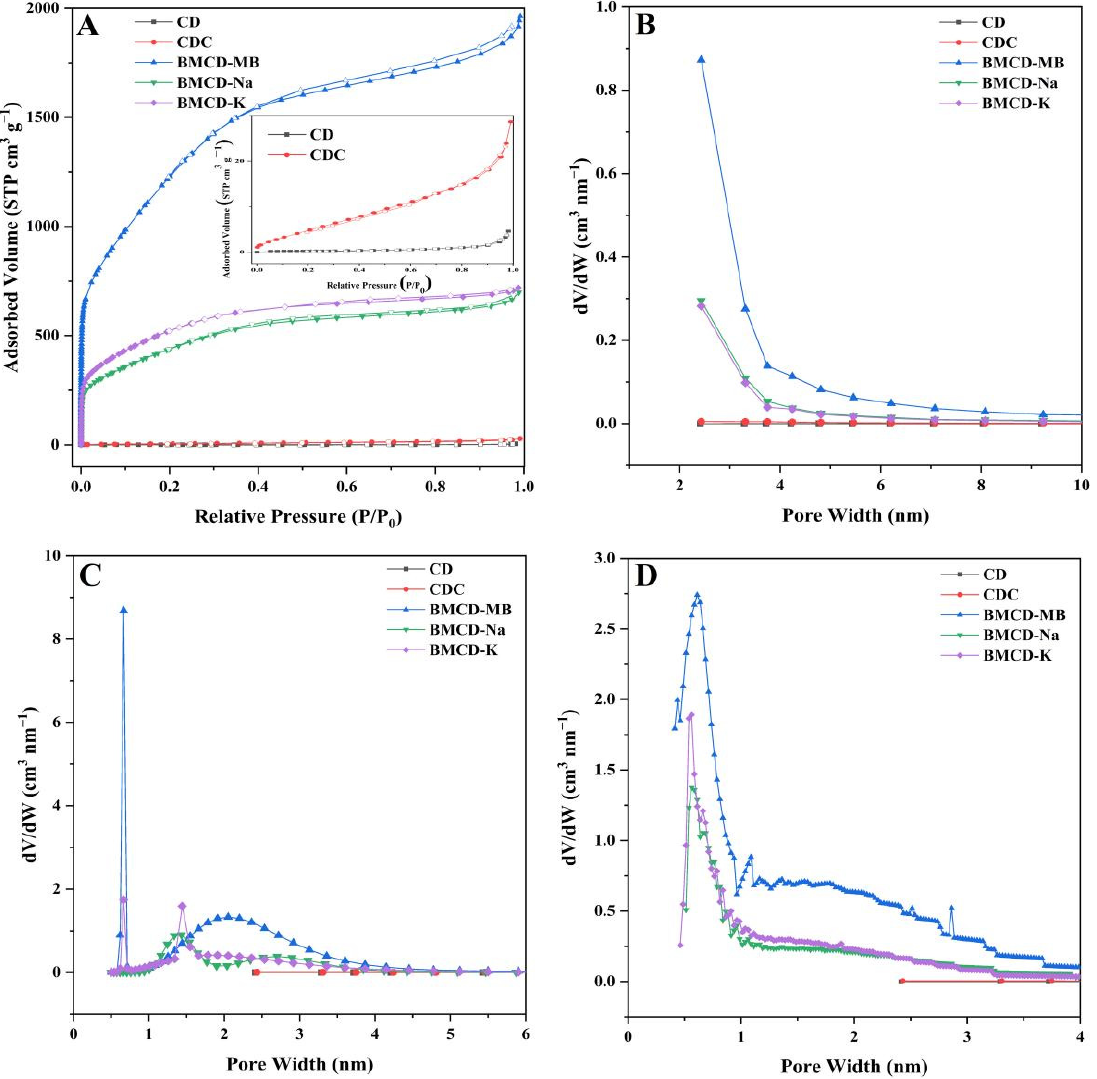
Figure 3. ( A ) N 2 adsorption-desorption isotherms of BMCD-K, BMCD-Na, and BMCD-MB (inset: N 2 adsorption-desorption isotherms of CD and CDC. Pore size distribution curves of CD, CDC, BMCD-K, BMCD-Na, and BMCD-MB based on ( B ) BJH, ( C ) NLDFT, and ( D ) H-K methods. Table 1. The data of N 2 adsorption-desorption for BMCDs prepared via different activators.